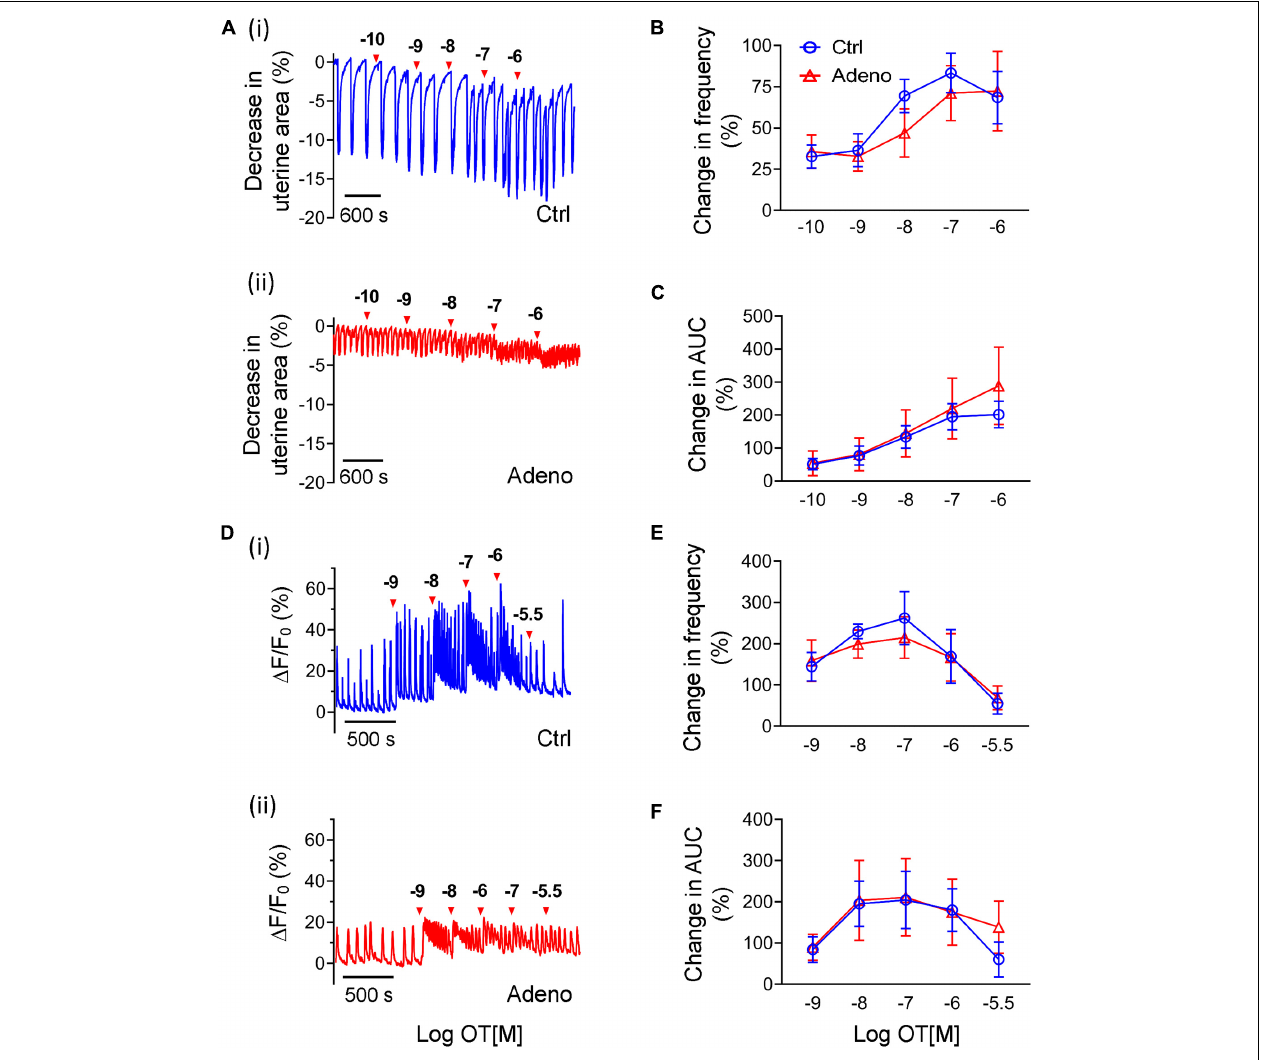
FIGURE 9 | Changes in oxytocin-induced uterine peristalsis and Ca 2 + oscillations in adult adenomyotic mice. (A) Time courses of uterine peristalsis in response to accumulative oxytocin (OT) stimulation in postnatal day (PND) 55 mice after treatment with the vehicle for tamoxifen (Ctrl) [A(i)] and the same age mice after treatment with tamoxifen (Adeno) [A(ii)] . The concentrations of oxytocin are labeled above the traces. (B) Uterine peristalsis frequency changes caused by oxytocin in uterine slices from Ctrl (O; blue line) and Adeno ( (cid:49) ; red line) mice at PND55. (C) Changes in the AUC of uterine peristalsis caused by OT in uterine slices from Ctrl (O) and Adeno ( (cid:49) ) mice at PND55. (D) Time courses of Ca 2 + oscillations in response to accumulative OT stimulation in Ctrl [D(i)] and Adeno mice [D(ii)] at PND55. The concentrations of OT are labeled above the traces. (E) Ca 2 + oscillation frequency changes caused by OT in uterine slices from Ctrl (O; blue line) and adeno ( (cid:49) ; red line) mice at PND55. (F) Change in the AUC of Ca 2 + oscillations by OT in uterine slices from Ctrl (O; blue line) and Adeno ( (cid:49) ; red line) mice at PND55. Note that a burst or a spike was counted as an event in this Figure (and Figure 10 ). N = 5 Ctrl mice (10 slices) and 5 Adeno mice (10 slices). A two-way ANOVA to compare individual groups shows no significant difference in panels (B,C,E,F)